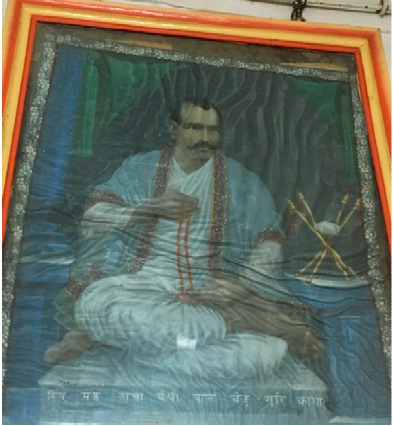
Figure 6. A painting of Ā c ā rya B ā lacandras ū ri hung in the up āś raya of the Cint ā ma ṇ i P ā r ś van ā th Temple at R ā m Gh ā ṭ . Twentieth century.